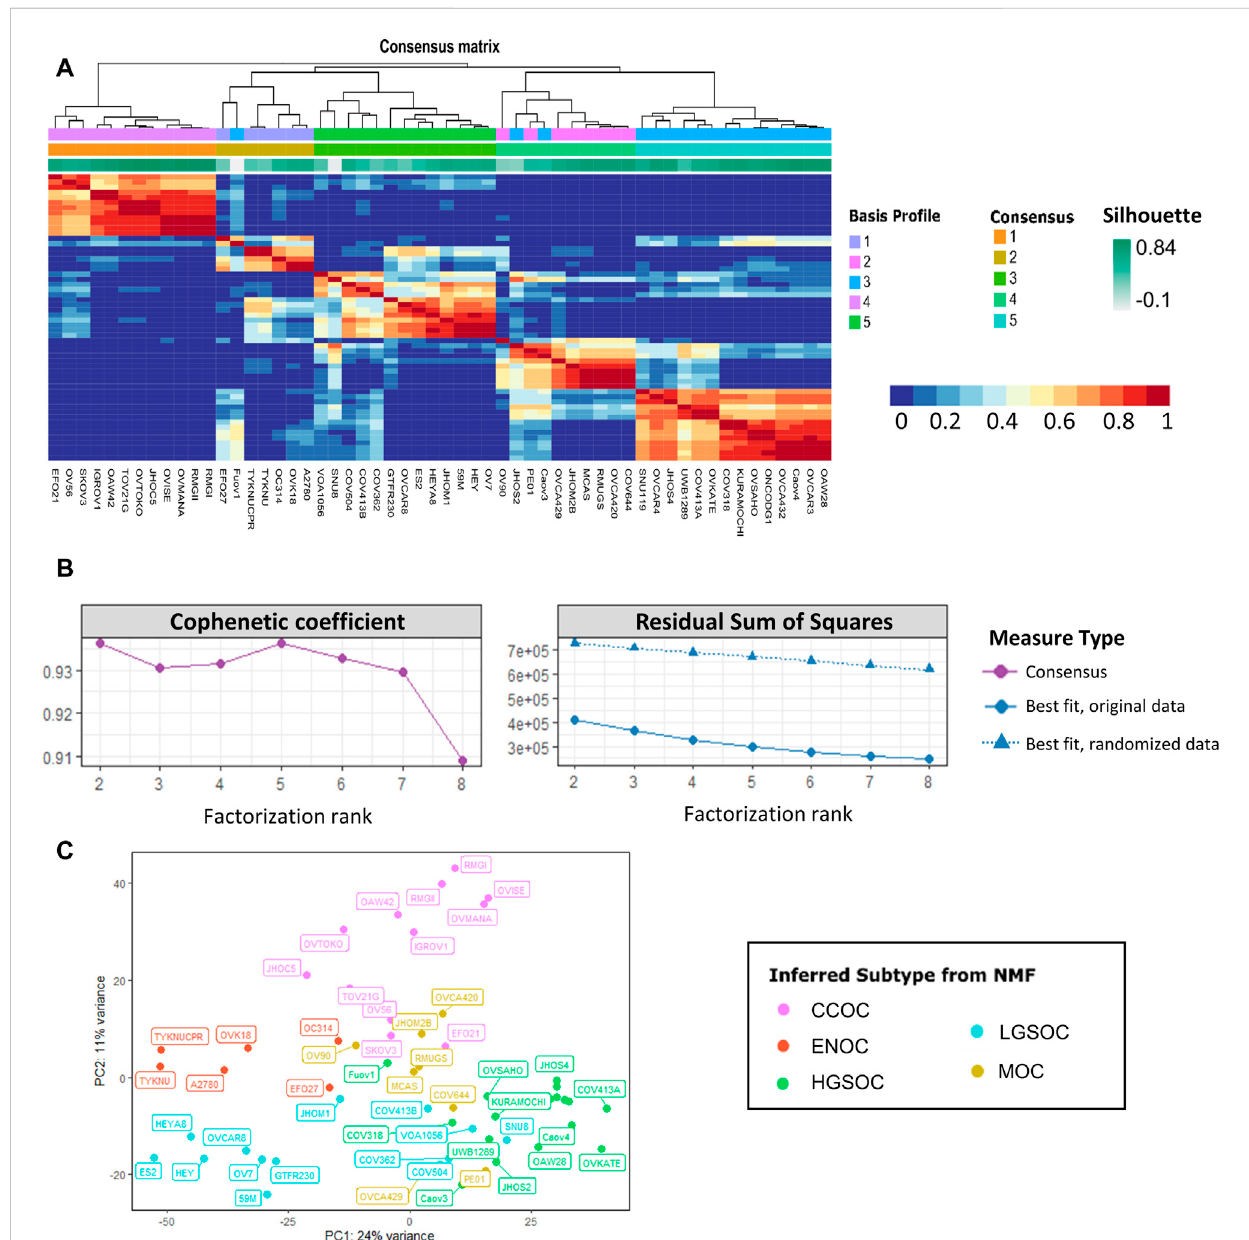
FIGURE 2 Non-negative matrix factorization separates 56 EOC cell lines into fi ve stable clusters. (A) Consensus map detailing cell line clustering for 200 NMF runsusingafactorizationrankof5.Thecolorsofeachheatmaptilerepresentthelikelihoodoftwocelllinesclusteringtogether.Rowsandcolumnsofthe map are symmetrically ordered by hierarchical clustering using the consensus matrix as a similarity measure. Above the heatmap are the associated dendogram, basis pro fi le, consensus and silhouette scores. (B) Factorization rank survey on both original and permuted data shows high quality metrics for a fi ve-group split. Left displays cophenetic correlation coef fi cient and right details the residual sum of squares for both the original and randomized data. Color and shape of points represent the type of measure used. (C) PCA plot of the 56 EOC cell line samples, colored by inferred NMF subtype, shows clustering of putative